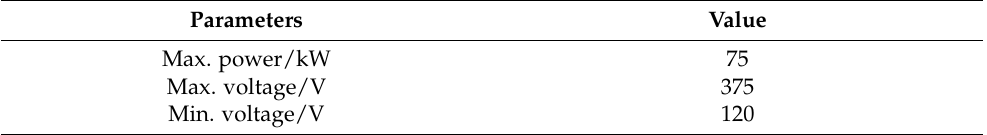
Table 4. Motor parameters.